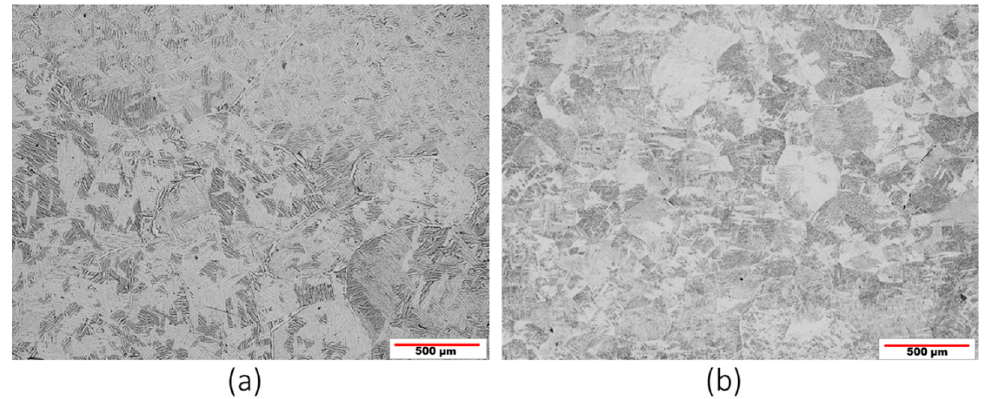
Figure 6. Optical micrograph of the Ti-6Al-4V alloy with Widmanstätten microstructure: ( a ) after the heat treatment and ( b ) after the plasma nitriding and creep test.